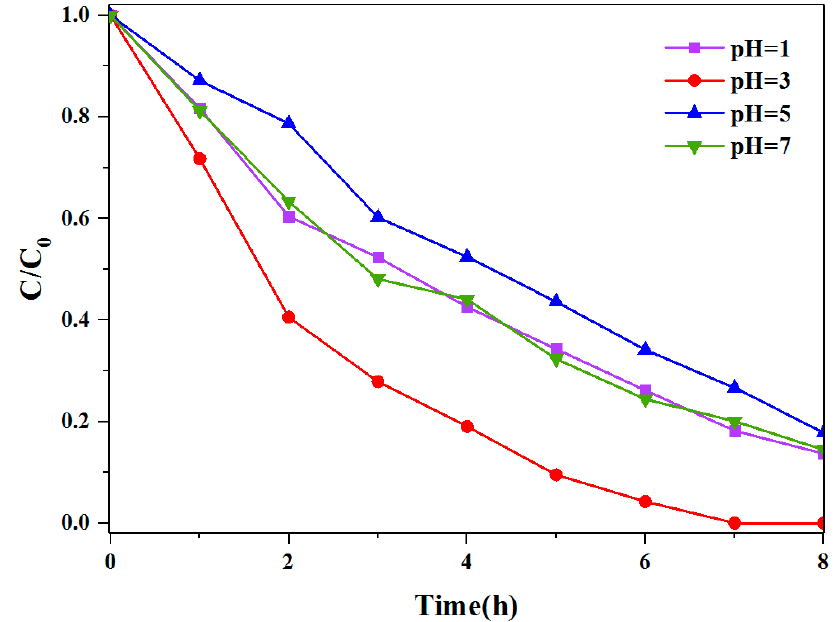
Figure 10. Activities of degradation phenol by CTAB-TCPP aggregates under different pH.